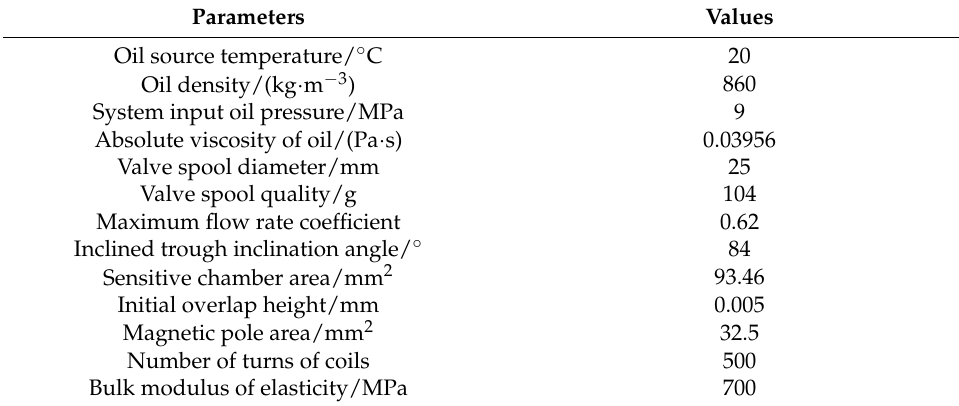
Figure 10. Simulation model of the 2D electric feedback flow control valve. AMESim simulation key parameter settings are shown in Table 2. Table 2. Key parameters of AMESim